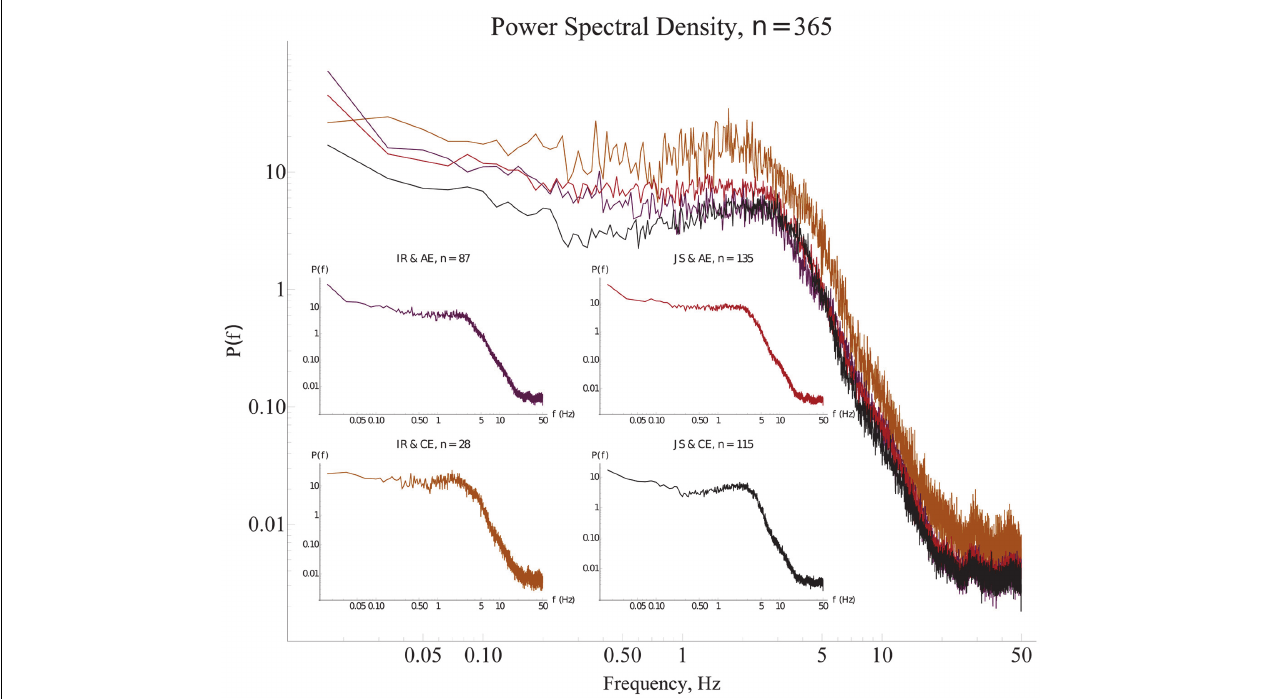
FIGURE 5 | Power spectra for different types of interaction. The median Fourier spectra for the four modalities of social interaction have similar shapes with a broad maximum in the range 0.5–5 Hz , and negligible power for higher frequencies. The time-series from the purple and black spectra (convergent cases) show less variability as shown by the smaller area under the spectra, in contrast with the orange and red spectra (divergent cases) in which the surface beneath the spectra are bigger. Insets: The red spectrum has the highest power; the purple and the black spectra have the smallest power; and the orange spectrum has intermediate power. The x axes are trimmed at the maximal possible frequency’s value according to Nyquist’s theorem (see details in Section “Fourier Spectral Analysis,” and in “Fourier Spectral Analysis” of the Supplementary Material). IR, individual response; JS, joint success; AE, ambiguous experience; CE, clear experience.